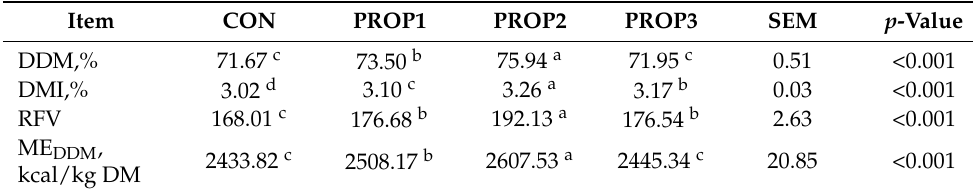
Table 8. DDM, DMI, RFV, and ME contents of alfalfa